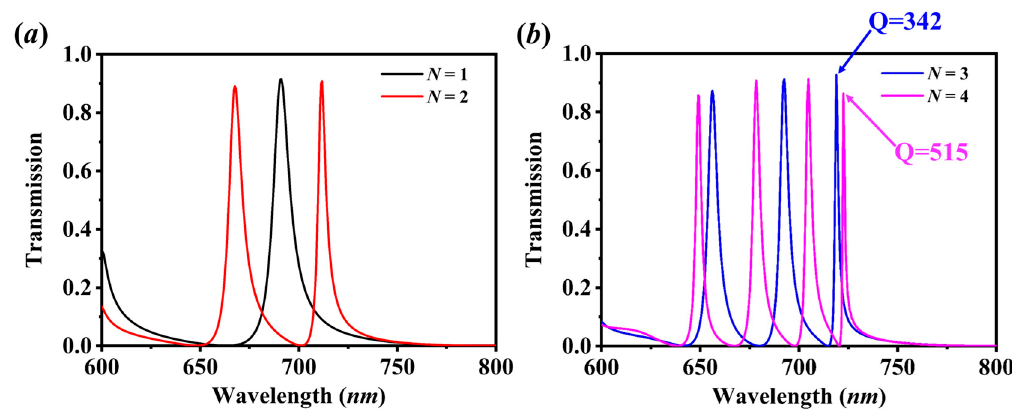
Figure 2. Transmission spectra of the ultra-thin metallic nanoslit arrays based on an N-layer stacked LID-HID with ( a ) N = 1 and N = 2 ( b ) N = 3 and N = 4.